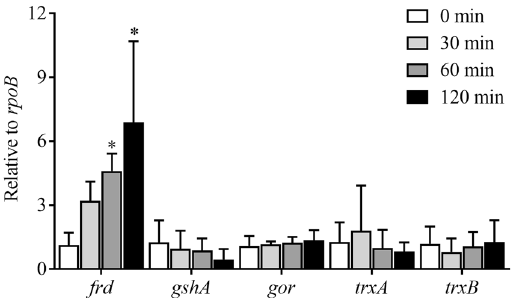
Figure 4. Effect of selenite on the transcription of fumarate reductase and enzymes involved in Painter-type reactions. An overnight culture of E. cloacae Z0206 was adjusted to OD 600 = 1 and diluted into fresh broth (1%). When the culture reached the stationary phase, a 2 ml sample of the culture was removed (as a Se-free control). A 500 μ L aliquot of the sodium selenite stock solution (1 M) was then added, and the culture was incubated for another 120 min. Samples were collected at 30 min, 60 min and 120 min after the addition of selenite. * P < 0.05, ** P < 0.01 (n =